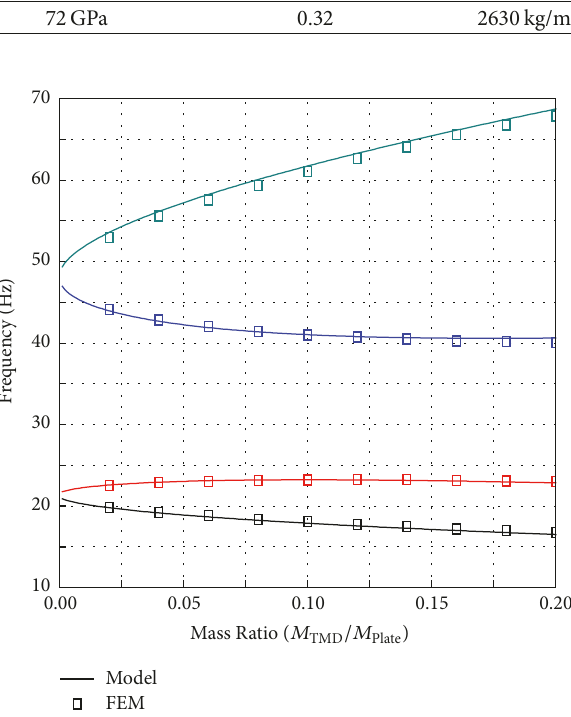
Figure 3: Comparison of frequency results for the presented model- ing and commercial FEM program for various mass ratios.